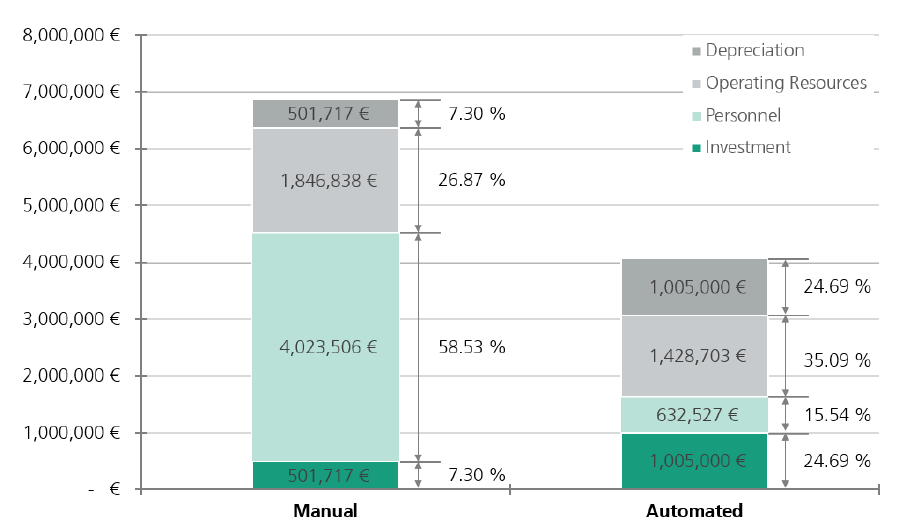
Figure 3. Cost distribution over machine lifetime (8 years) for manual and automated iPSC pro- duction.